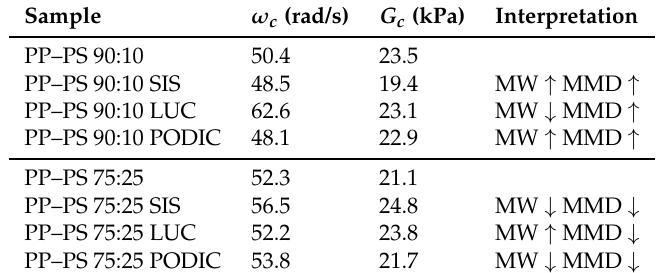
Table 3. Summary of G (cid:48) = G (cid:48)(cid:48) crossover point values obtained from dynamic rheology measurements.